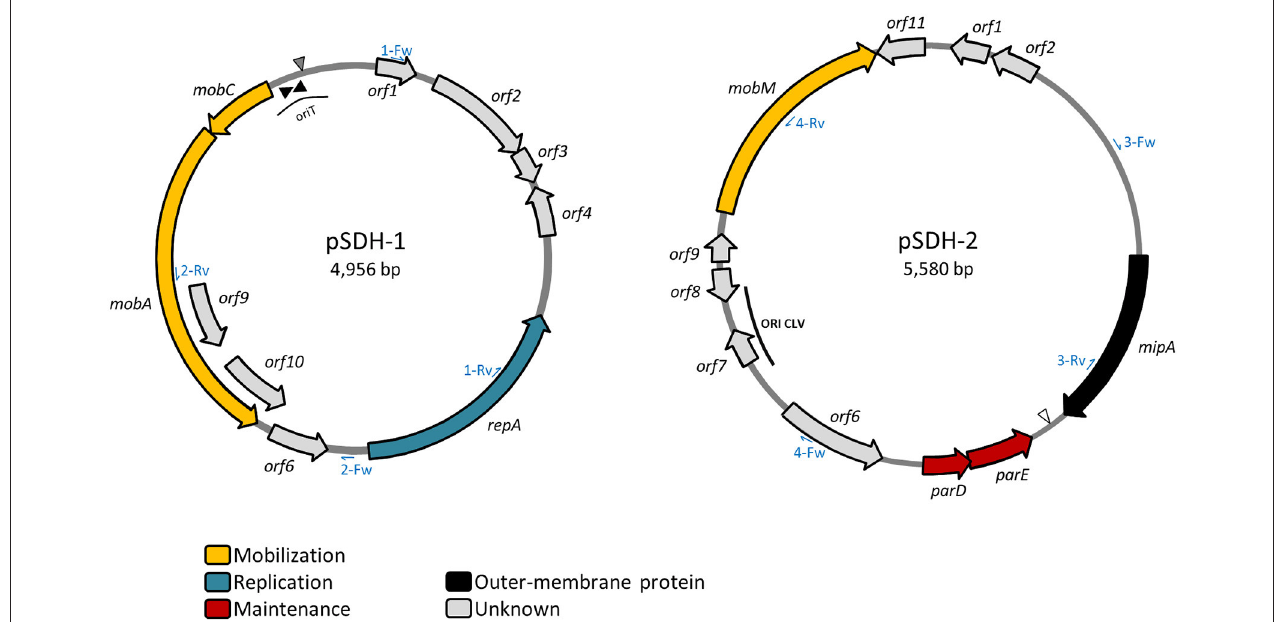
FIGURE 1 | Schematic representation of plasmids pSDH-1 and pSDH-2. Predicted open reading frames (ORFs) are indicated by arrows pointing in the direction of transcription. ORFs to which a putative function could be assigned are color-coded. Size of the plasmids is indicated. Position of the inverted repeats of the putative oriT region of pSDH-1 are indicated by black triangles. Location of the putative nic site is indicated by a gray triangle. The open triangle indicates the position of the putative xer recombination site of pSDH-2. The position of the putative CLV-like origin of replication of pSDH-2 is indicated. Position of PCR primers used for screening for the presence of both plasmids are indicated by blue half-arrows and are labeled with the number of the set followed by Fw (forward) or Rv (reverse).